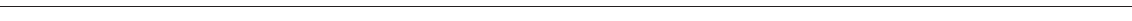
FIGURE 2 | maximum intension projection (MIP) demonstrating low neutrophil recruitment and persistence in control Catchup IVM − red mice injected with PBS + Qtracker ® at day0. At day 0 the Qtracker dye ( + PBS) (cyan) was injected into the ear dermis only. On day 3 and 6 blood vessels were labeled by i.v. Qtracker ® (blue) injection. Yellow asterisks mark hair follicles (day 0). Dotted white line indicate areas of invaginated epidermal layer (wrinkle) with high red autofluorescence. Scattered neutrophils are represented by cell-associated red signals in the tissue parenchyma. (F–I) Velocities of neutrophils in the tumor compartments assessed by semi-automated tracking. (J–L) Migration of TAN in (F–H) was also analyzed for directionality (track length/displacement). (F–L) n = 4 for tumor bearing mice, n = 2 for PBS, n = 3 in (I) and cumulative number of analyzed single neutrophils depicted in each plot. Statistical significance was assessed with paired t -test (B–D) and unpaired two-tailed t -test (F–L) , α = 0.05. Mean + /– SEM is shown in bar graphs and 5–95% percentiles in boxplots. 3D reconstruction, quantification and tracking were performed with Imaris ®